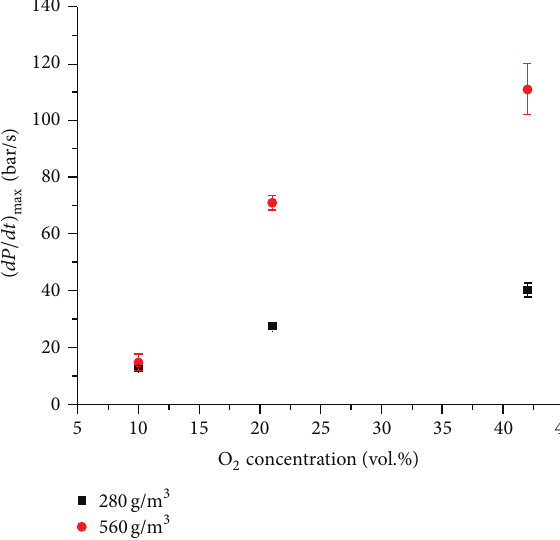
Figure 6: Maximum rate of pressure rise (absolute pressure) within the 31L chamber from sulfur